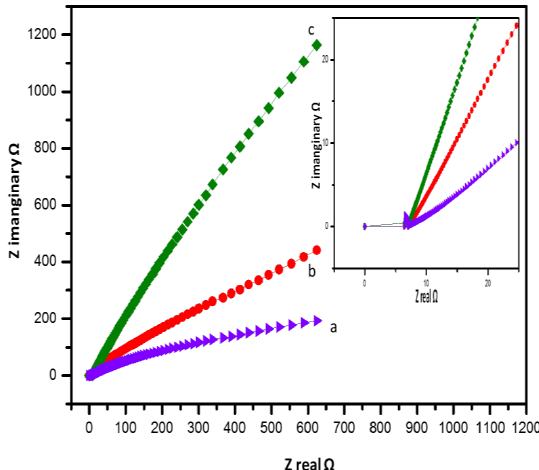
Figure 7. The ionic conductivity of the conductive A/P:P hydrogel electrolyte was deter-